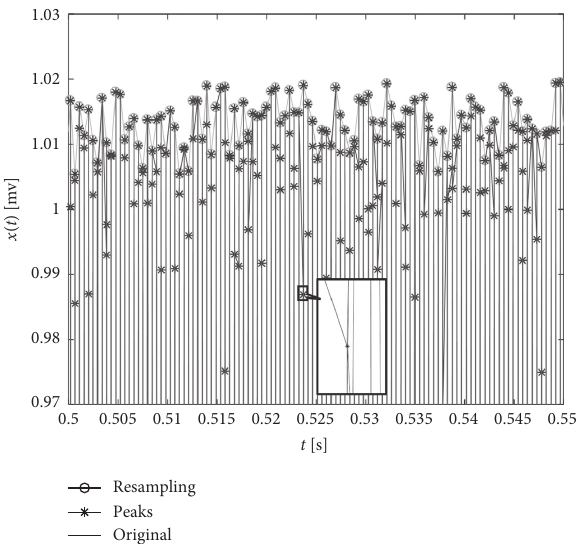
Figure 10: Comparison of DSLR and find-peaks methods on t